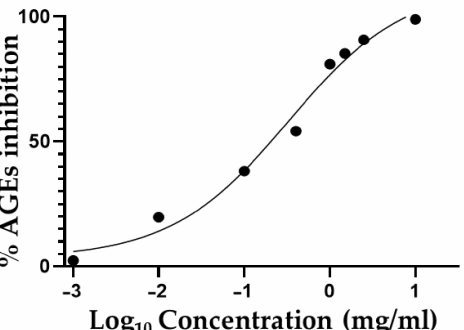
Figure 4. Inhibition of advanced glycation end-product formation (%) by OAALE. Values represent the mean ± standard deviation of triplicate